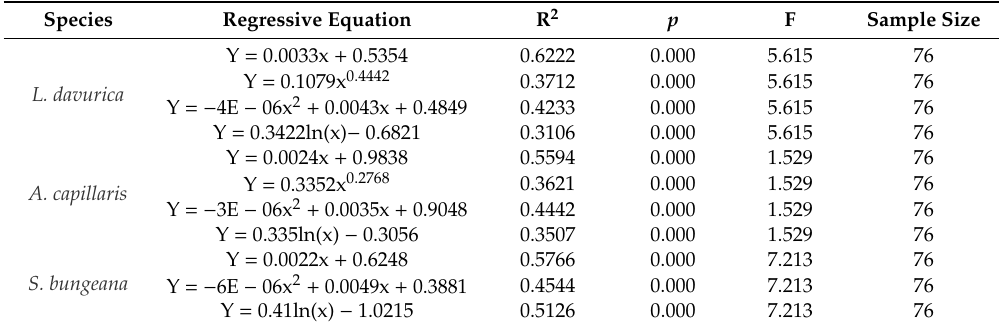
Table 2. Regressive equations of the product of plant height (PH) and canopy diameter (CD) (PC) of dominant species predicting AGB of the same species.